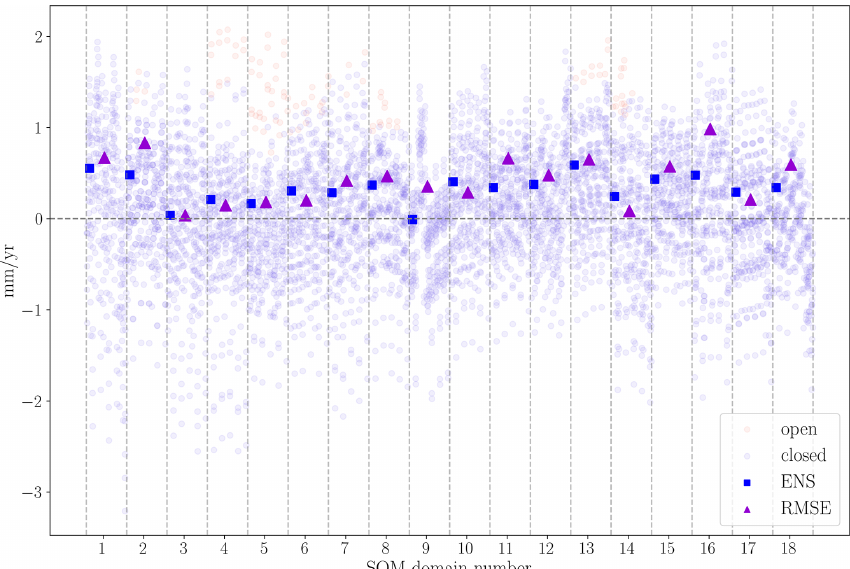
Figure 6. Budget residuals (mmyr − 1 ) for all possible data set combinations for every SOM domain (separated by vertical dashed lines). The ensemble mean combination (used for the main analysis) is indicated with squares. The RMSE combination, that is, the budget combination that uses the individual data set with smallest RMSE in relation to the ensemble mean for each component, is indicated with